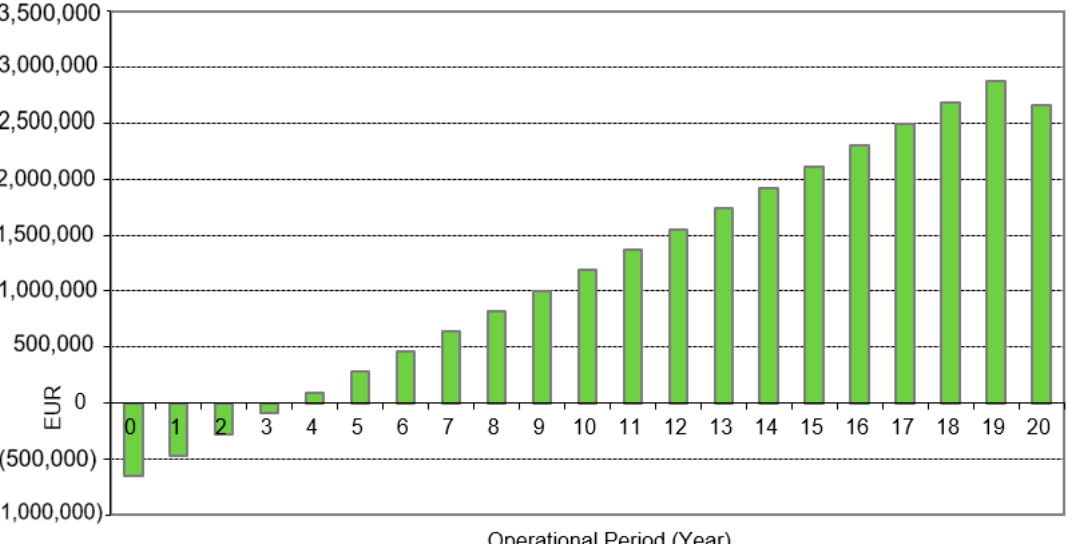
Figure 7. Energies 2020 , 13 , x FOR PEER REVIEW